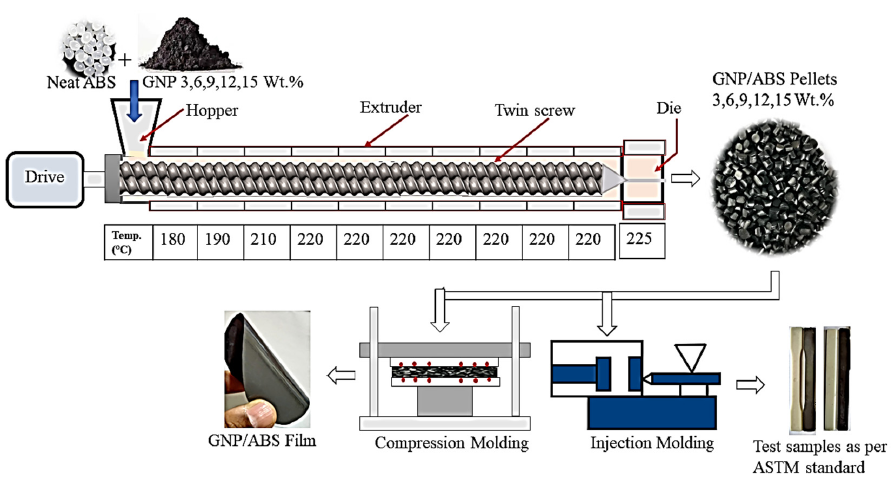
Figure 1. Schematic diagram of ABS+GNP nanocomposite film and test sample preparation.